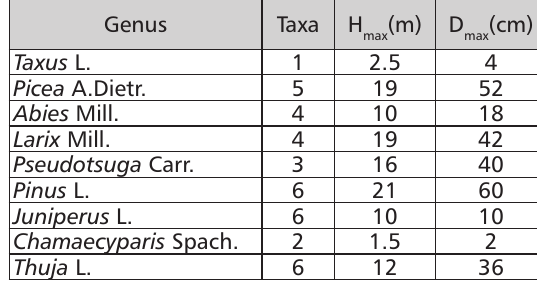
TABLE 2 Composition of the highest and thickest conifers by